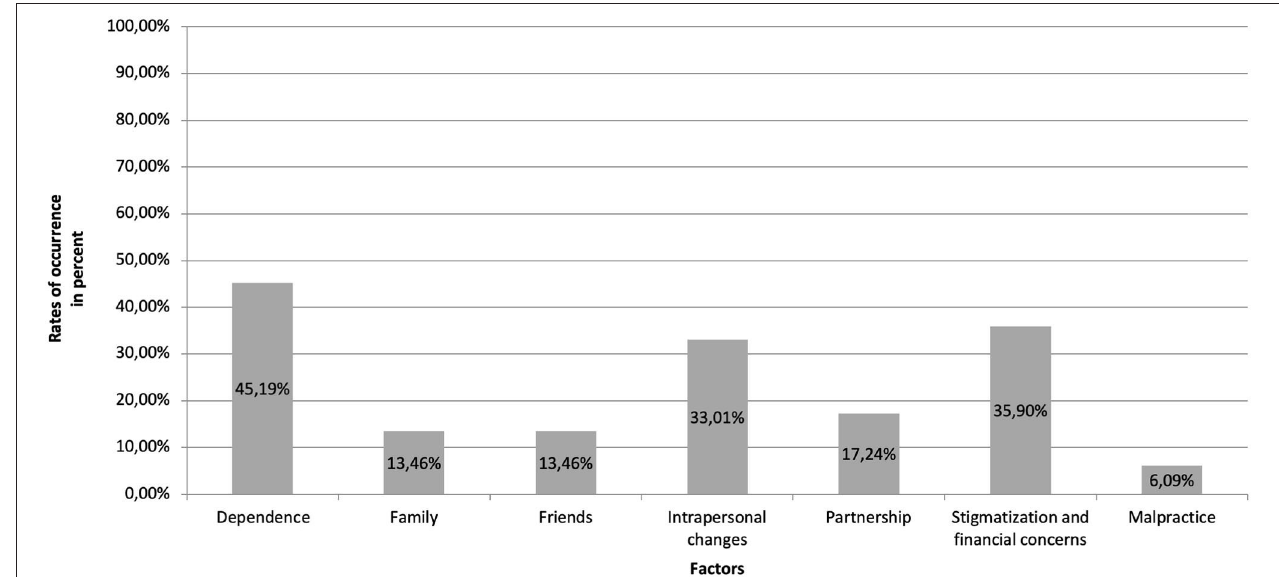
FIGURE 1 | Rates of occurrences of reported negative effects of psychotherapy according to the seven factors of the INEP (3).